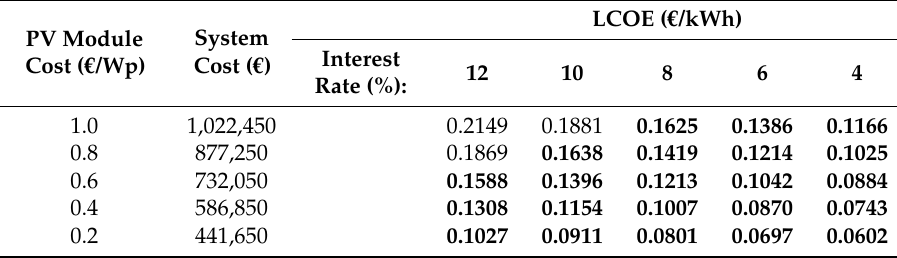
Table 13. LCOE over a range of interest rates (50,000 W inverter, deterministic method).